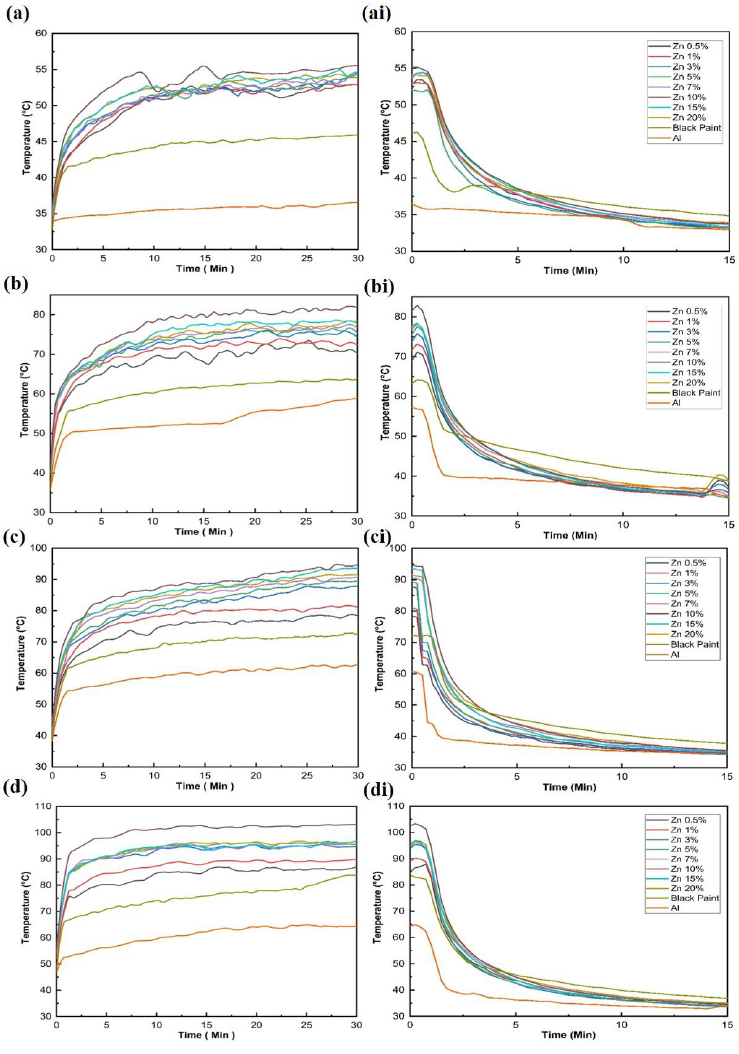
Figure 6. Effect on absorber temperature at irradiation exposure of ( a ) 200 W/m 2 , ( b ) 600 W/m 2 , ( c ) 800 W/m 2 , and ( d ) 1000 W/m 2 and temperature-drop profile ( ai , bi , ci , and di ).